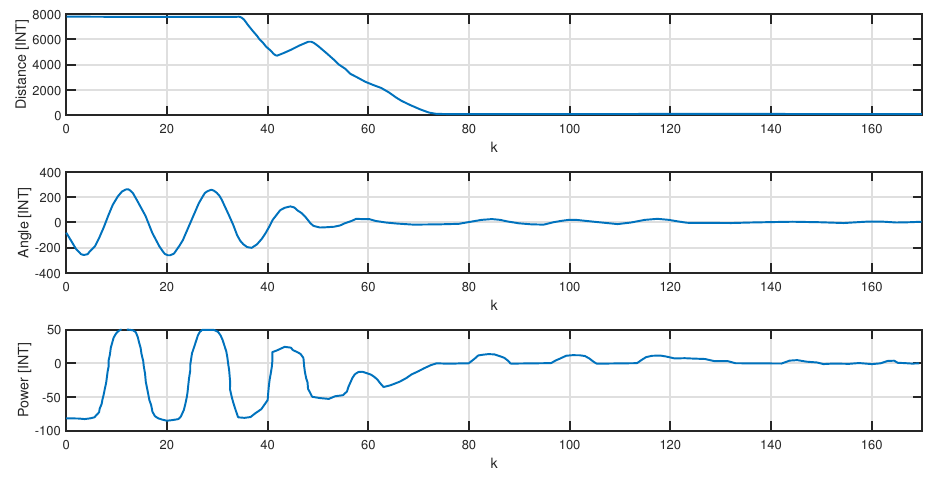
Figure 9. Fuzzy control with disturbance in the beginning.